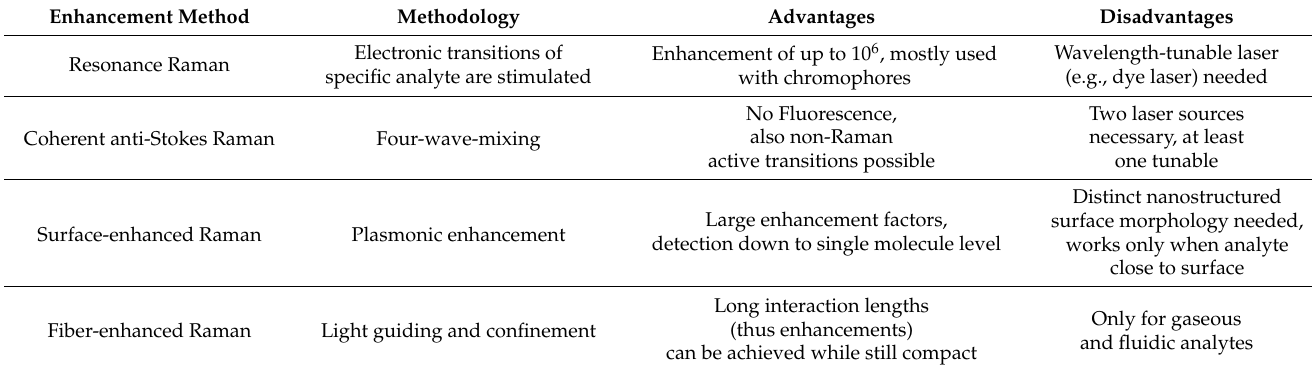
Table 1. Comparison of the different enhancement methods mentioned in the